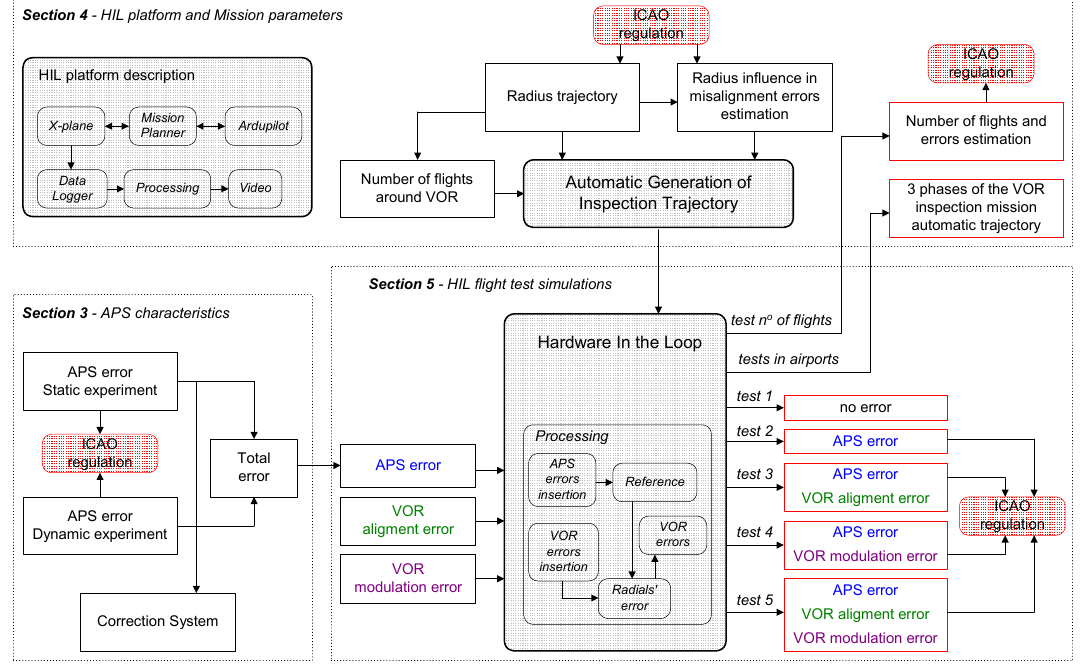
Figure 2. Flowchart showing the global approach for assessing the feasibility.